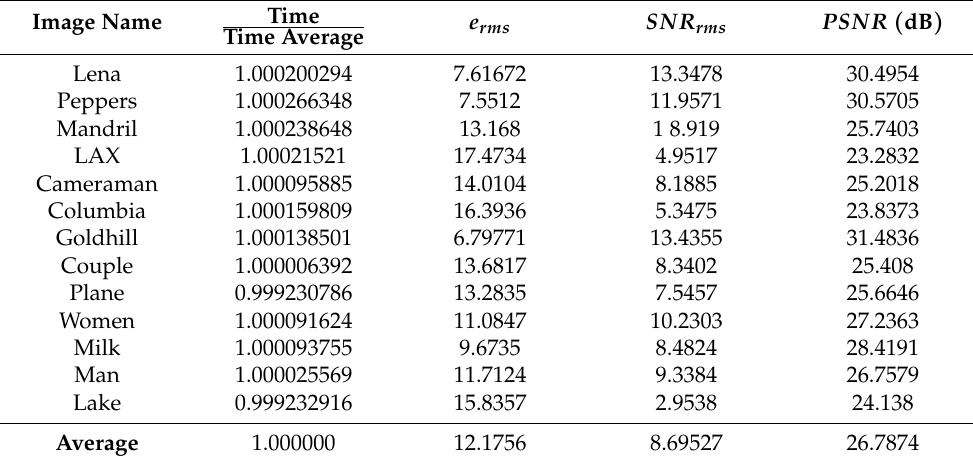
Table 3. Performance of the Barnsley’s algorithm [45] on various images.